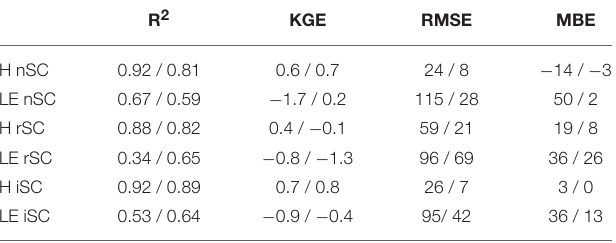
TABLE 2 | Statistics of model performance for all days for both the latent and sensible heat flux for the three different models. R 2 KGE RMSE MBE H